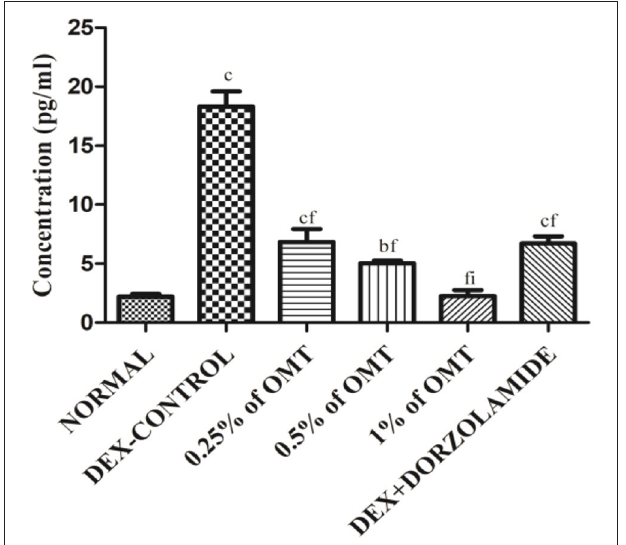
FIGURE 7 | Effects of OMT on the expression of TGF β 1. Values are expressed as mean ± SEM ( n = 6). Data were analyzed by one-way ANOVA and are expressed as a p < 0.05, b p < 0.01, c p < 0.001 when compared to normal group, d p < 0.05, e p < 0.01, f p < 0.001 when compared to DEX-induced glaucoma control group, and g p < 0.05, h p < 0.01, i p < 0.001 when compared to standard group, respectively. Normal: 100 µ l of distilled water; control: 0.1ml of 0.1% DEX solution; treatment 1: 50 µ l of 0.25% OMT solution; treatment 2: 50 µ l of 0.5% OMT solution; treatment 3: 50 µ l of 1% OMT solution; standard: 100 µ l of 1% of dorzolamide solution.